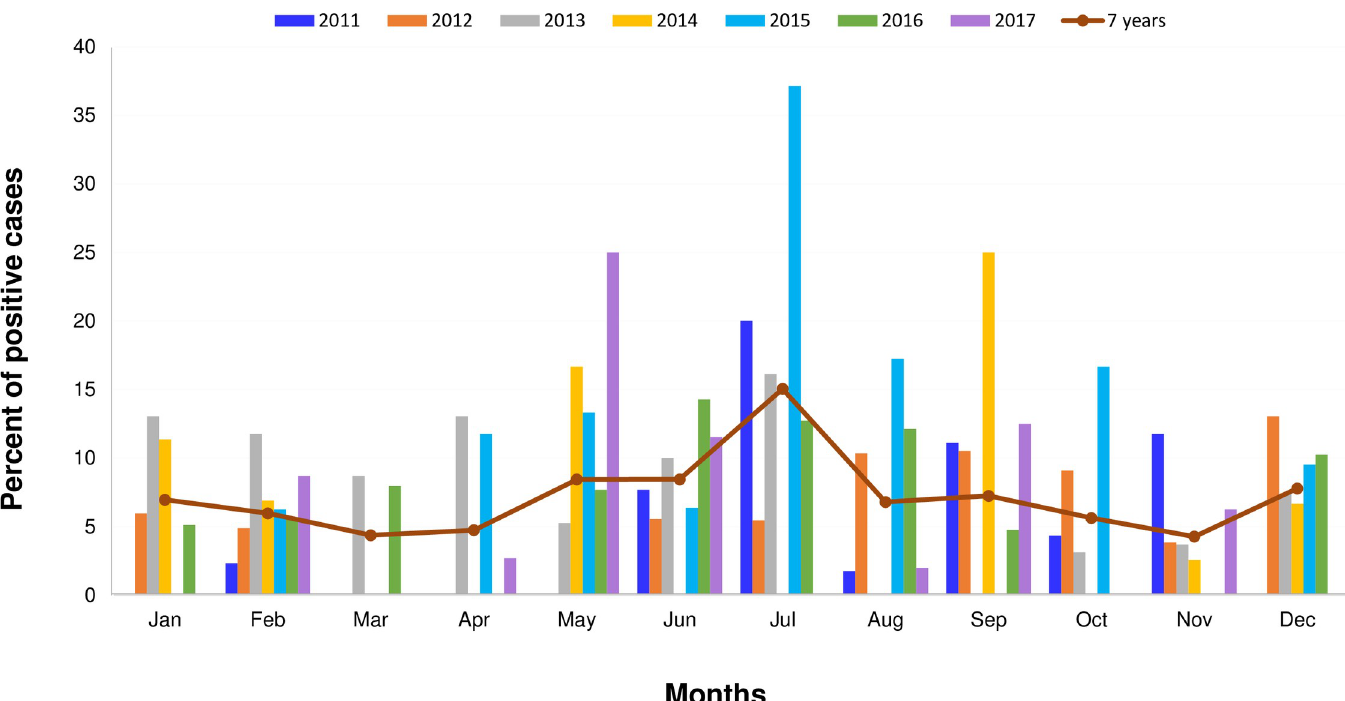
Fig 2. Monthly distribution of adenovirus infections in Thai patients with acute gastroenteritis from 2011 to